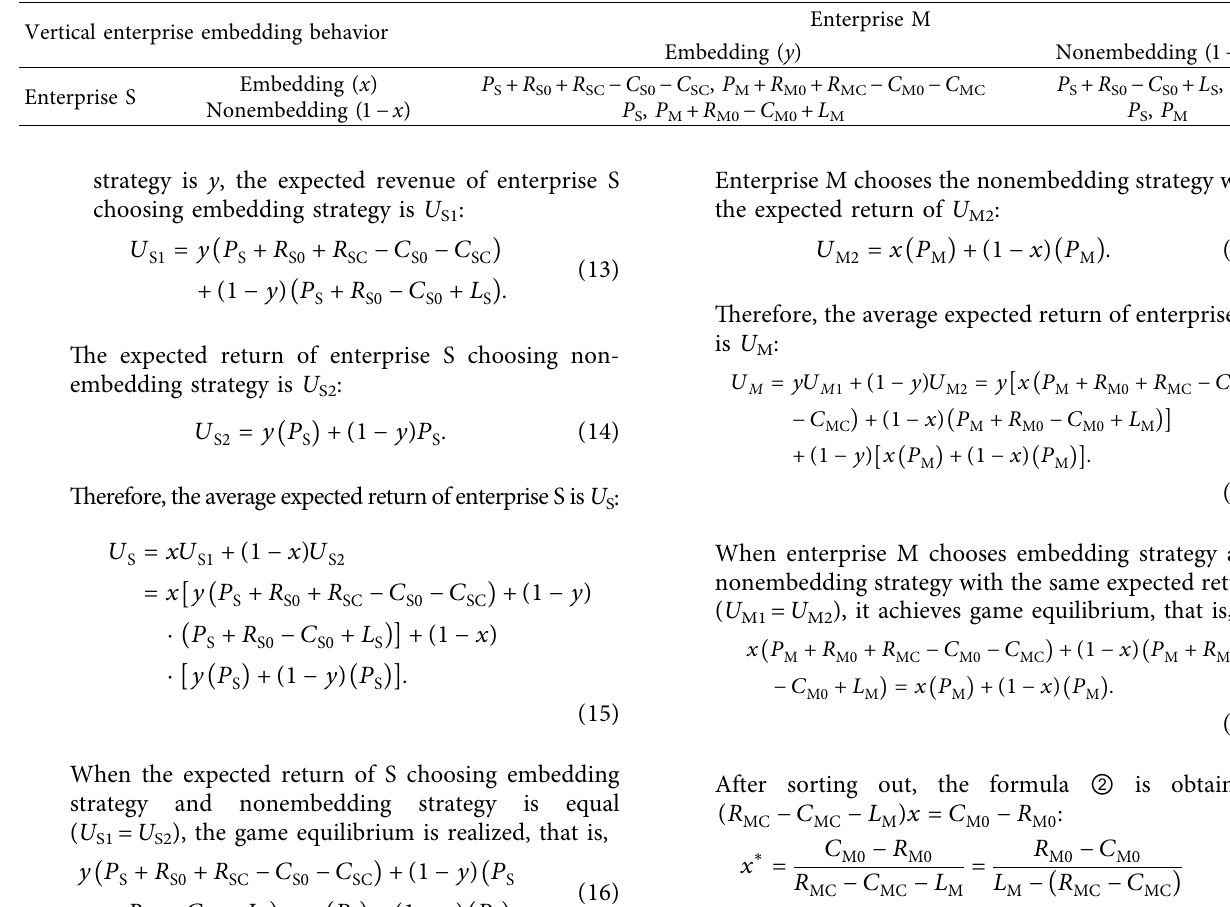
Table 4: Revenue matrix of vertical